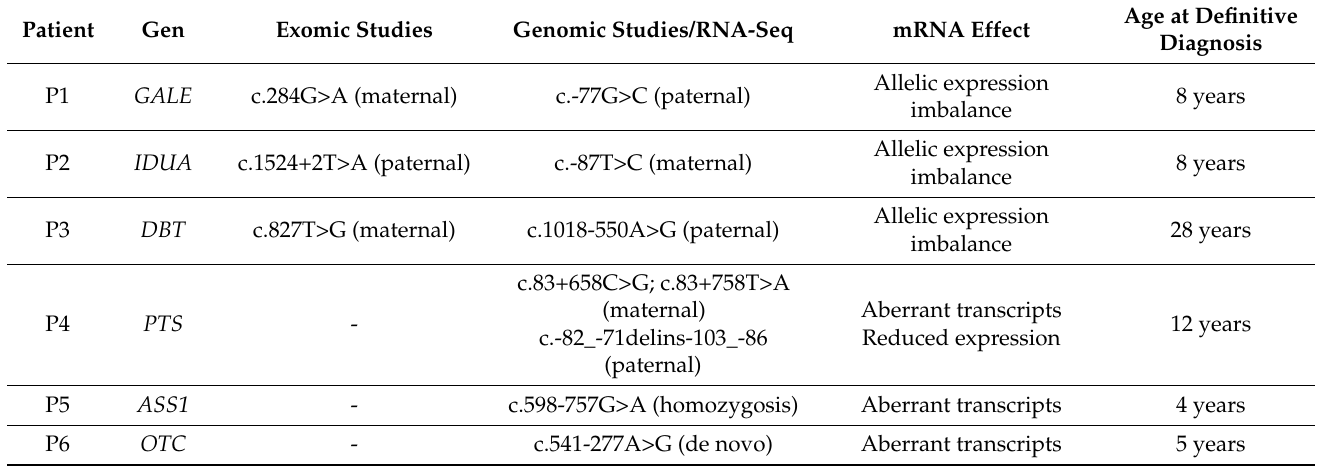
Table 2. Genetic findings. Affected gene, variants identified by exomic or genomic sequencing, mRNA effect and age at definitive